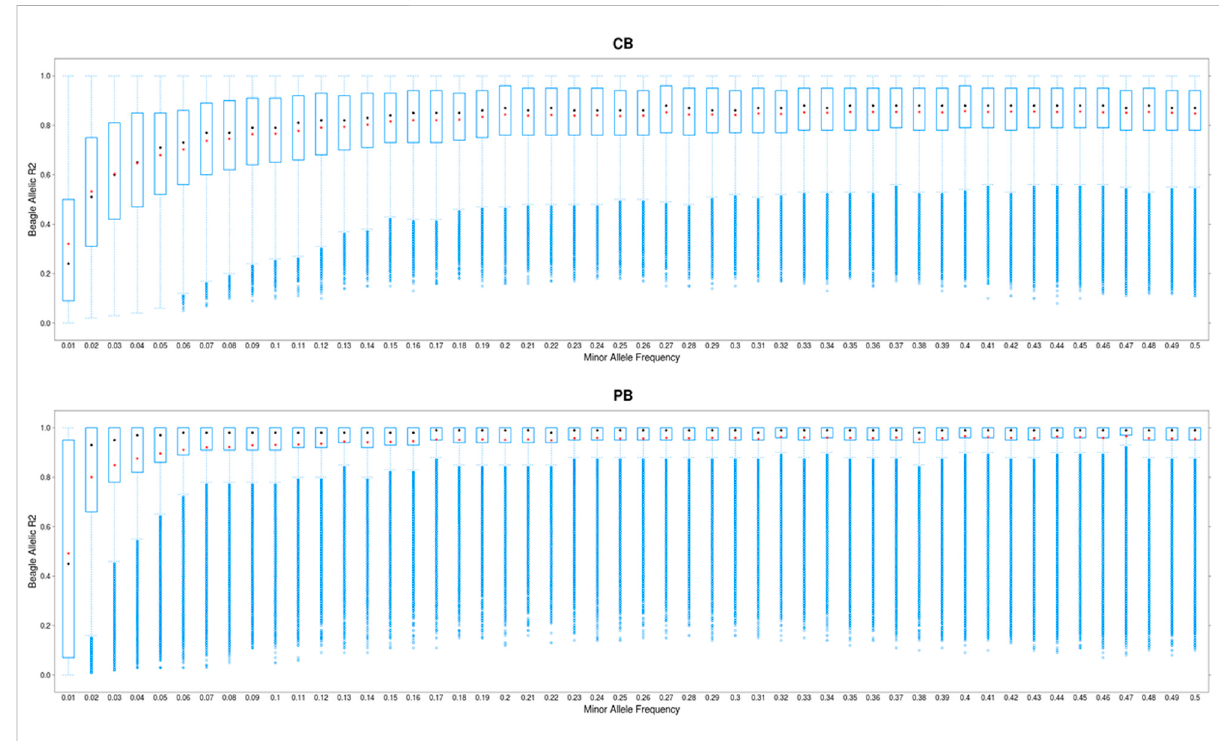
FIGURE 2 Boxplot showingtheimputation accuracy(allelicDR 2 )to whole-genome sequence(WGS) versus minorallele frequency(MAF) forCBsand PBs. The x -axis represents different classes of MAF (ranging from 0.01 to 0.5, with thesteps of 0.01), and y -axis shows the imputation accuracies. The red and black dots are the mean and median of imputation accuracies across individuals in each MAF